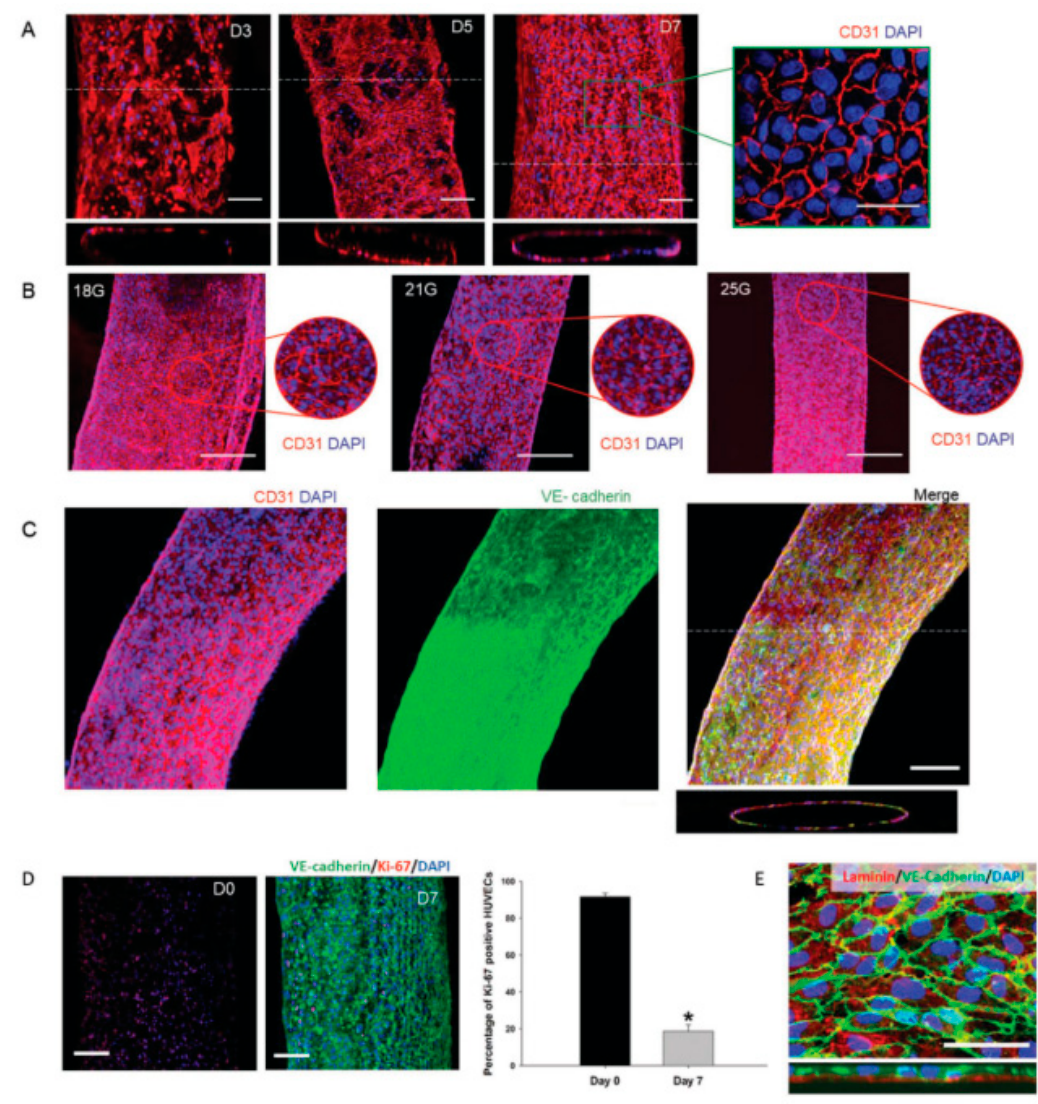
Figure 5. Formation and maturation of the endothelium after three, five and seven days of culture (scale bars are 100 and 50 µm in the inset) ( A ). Vessel formation using different needle diameters for bioprinting (scale bar is 200 µm) ( B ). CD31 and VE-cadherin expression after seven days of culture (scale bar is 100 µm) ( C ). Ki-67 and VE-cadherin staining demonstrated the decrease of proliferation cells and the consequent vessel stabilization (scale bar is 100 µm. * p < 0.005, N = 3) ( D ). Detection of laminin in the basolateral side of the endothelial layer (scale bar is 20 µm) ( E ). Reprinted from Reference [37], with permission from John Wiley and Sons.